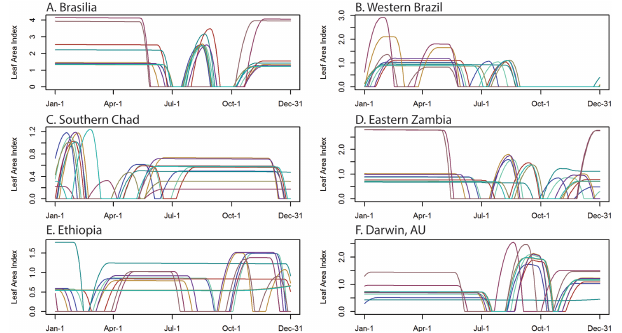
Figure 4. Illustration of Latin hypercube (LH) variable exploration analysis results – here each line represents one simulation from 1 year of the LH analysis without the additional rainfall trigger. Each line is from a model run with slightly different values for the vari- ables considered. In actuality 100 simulations were performed, but for visual clarity we are showing a selection of 10